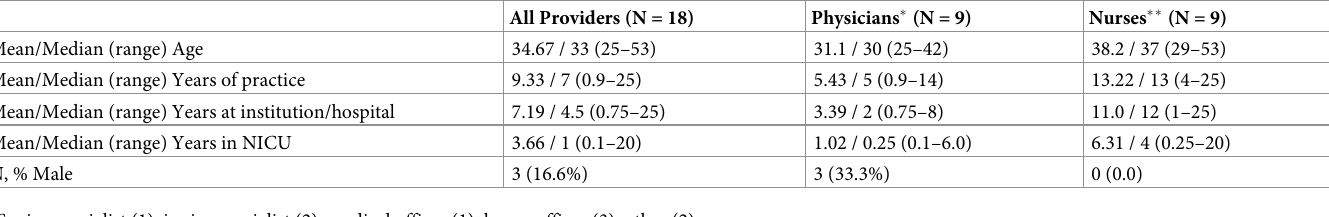
Table 2. Health care provider